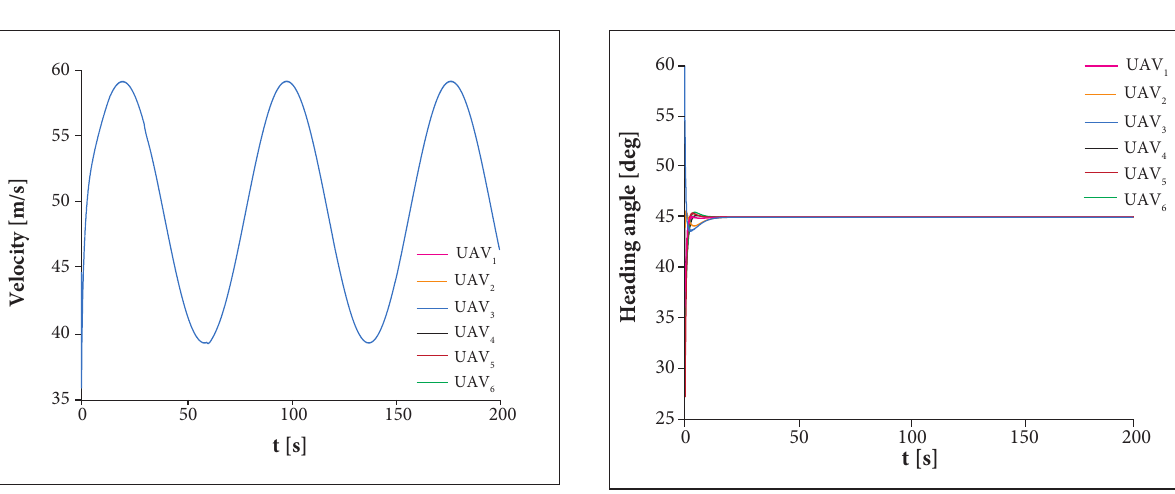
figure 7. Time histories of the height.